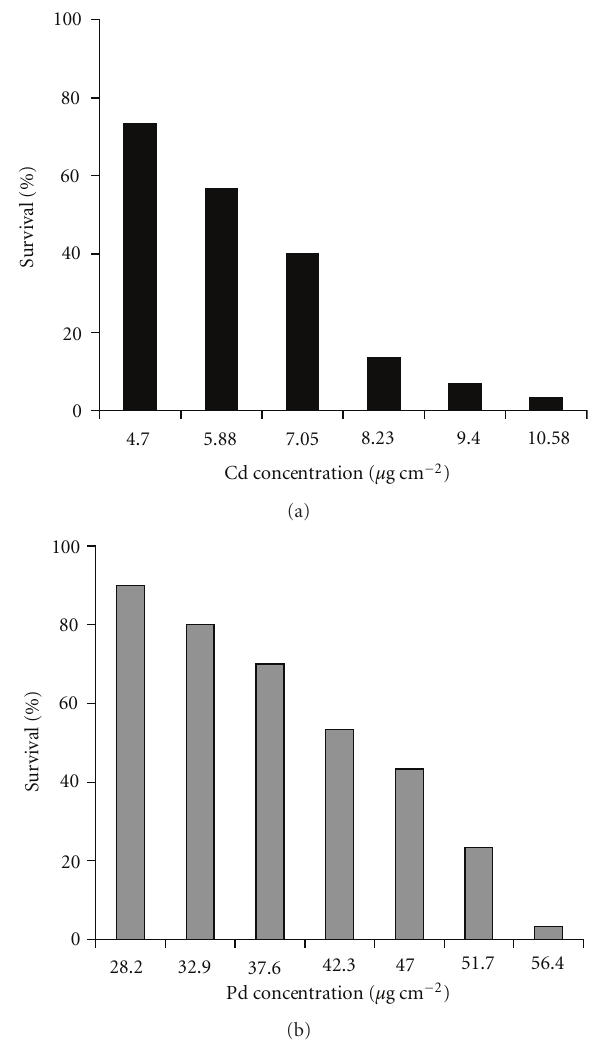
Figure 1: Percentage survival of Pheretima peguana exposed to (a) Cd and (b) Pb in filter paper for